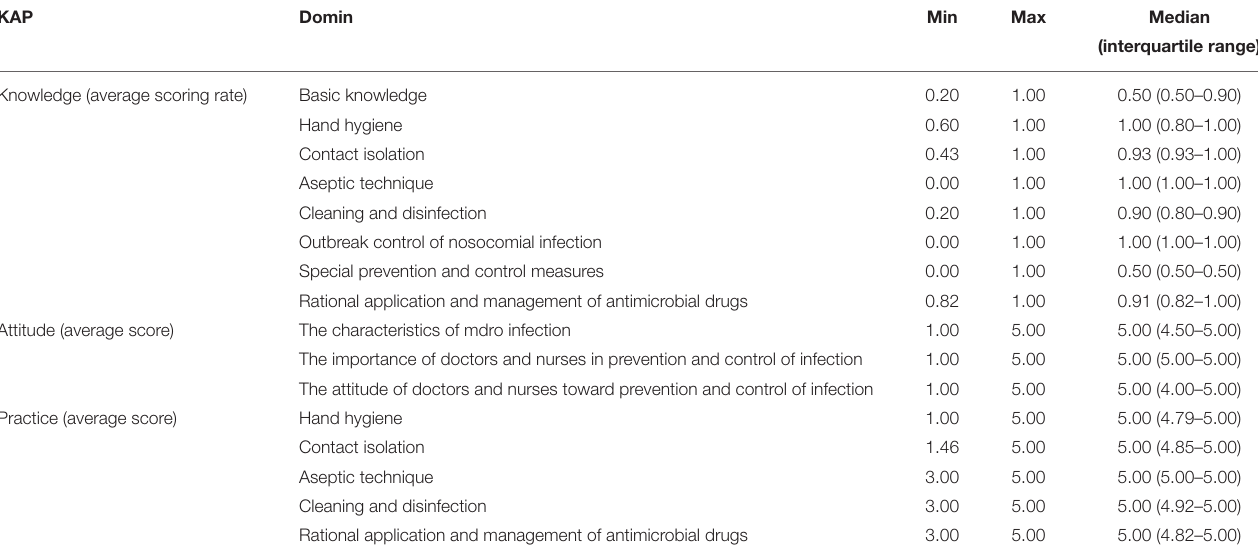
TABLE 2 | The knowledge, attitudes, and practices (KAP) † of neonatal intensive care units (NICU)‡ doctors and nurses. KAP Domin